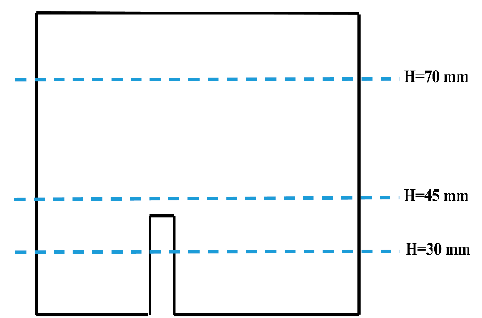
Figure 28. Density profile along the radius (stub hole): experiment vs. finite element result (h = 80 mm).